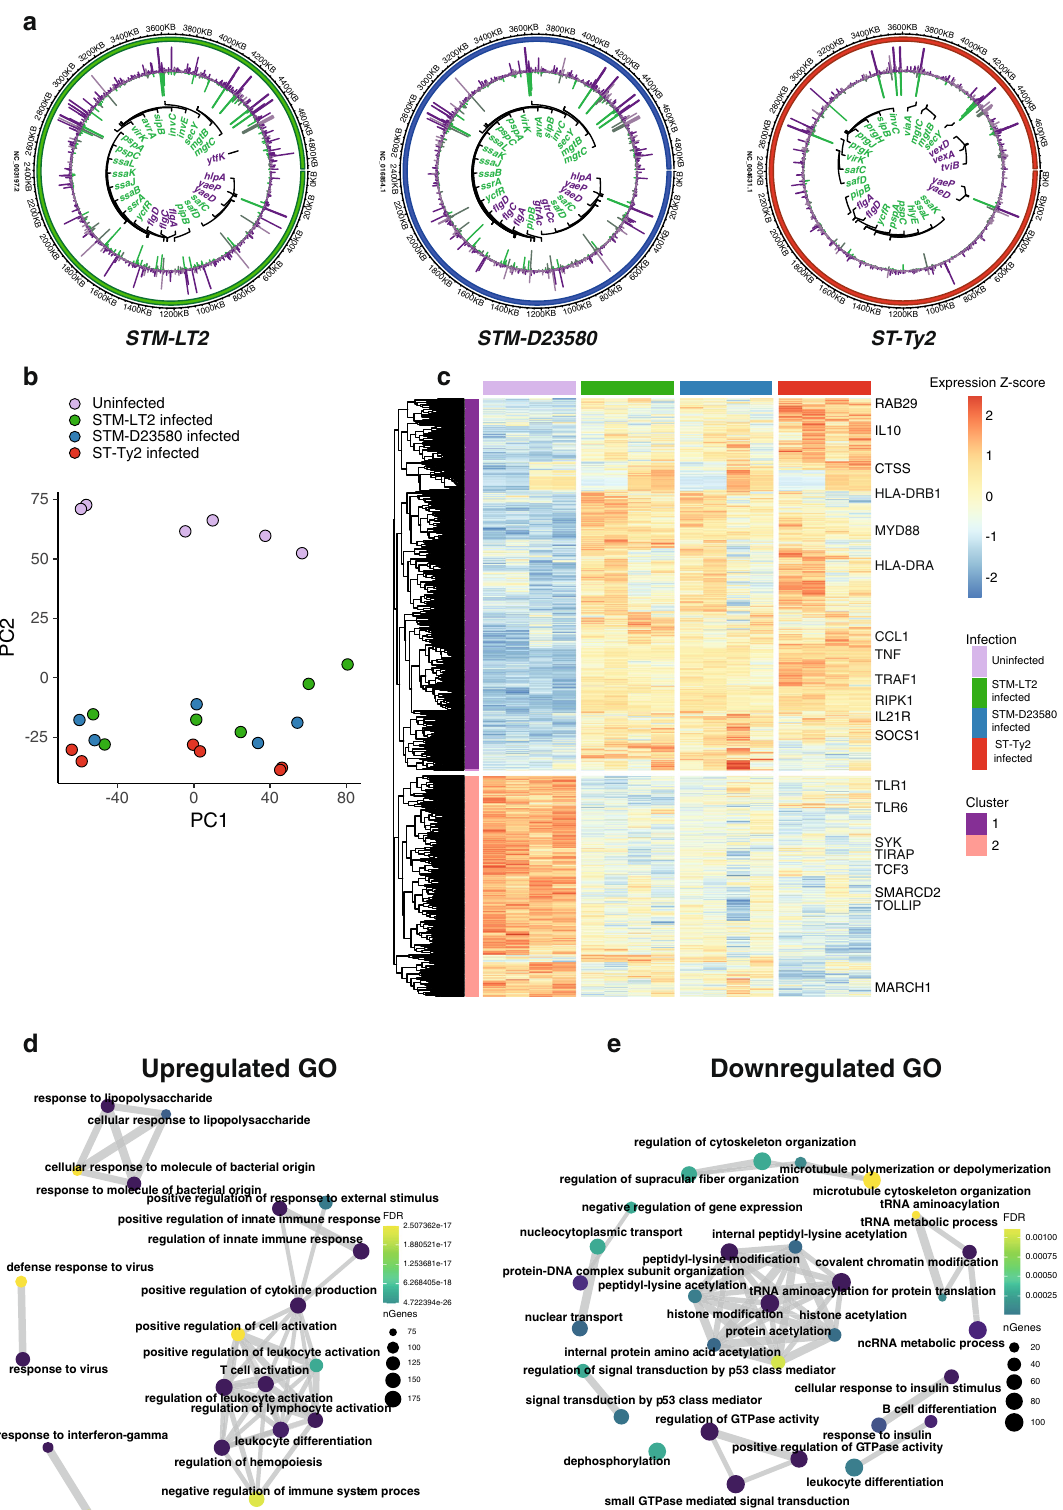
Dendritic cells reprogramming in response to invasive Sal- and ST-Ty2-infected MoDCs, 1757 DE genes between STM- monella serovars . To identify unique differences between MoDCs D23580 and ST-Ty2-infected MoDCs, but only 450 genes were found being DE between STM-LT2 and STM-D23580-infected infected with the three bacterial strains, we directly compared MoDCs (Supplementary Fig. 3 and Supplementary Data 5). host cell gene expression between STM-D23580, STM-LT2 and The differences identi fi ed in gene expression in STM-D23580 ST-Ty2-infected MoDCs. We found 2265 genes (false discovery versus STM-LT2 or ST-Ty2-infected MoDCs suggested that rate, FDR < 5%) differentially expressed (DE) between STM-LT2- COMMUNICATIONS BIOLOGY| (2022) 5:111